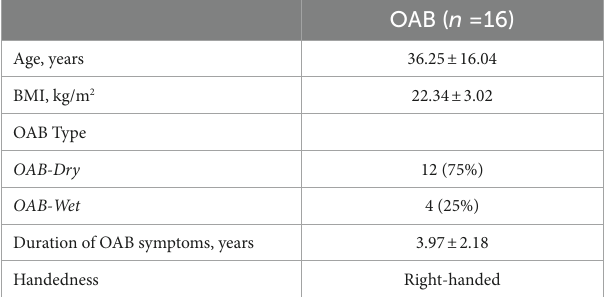
TABLE 2 Baseline demographic and clinical characteristics of successfully treated